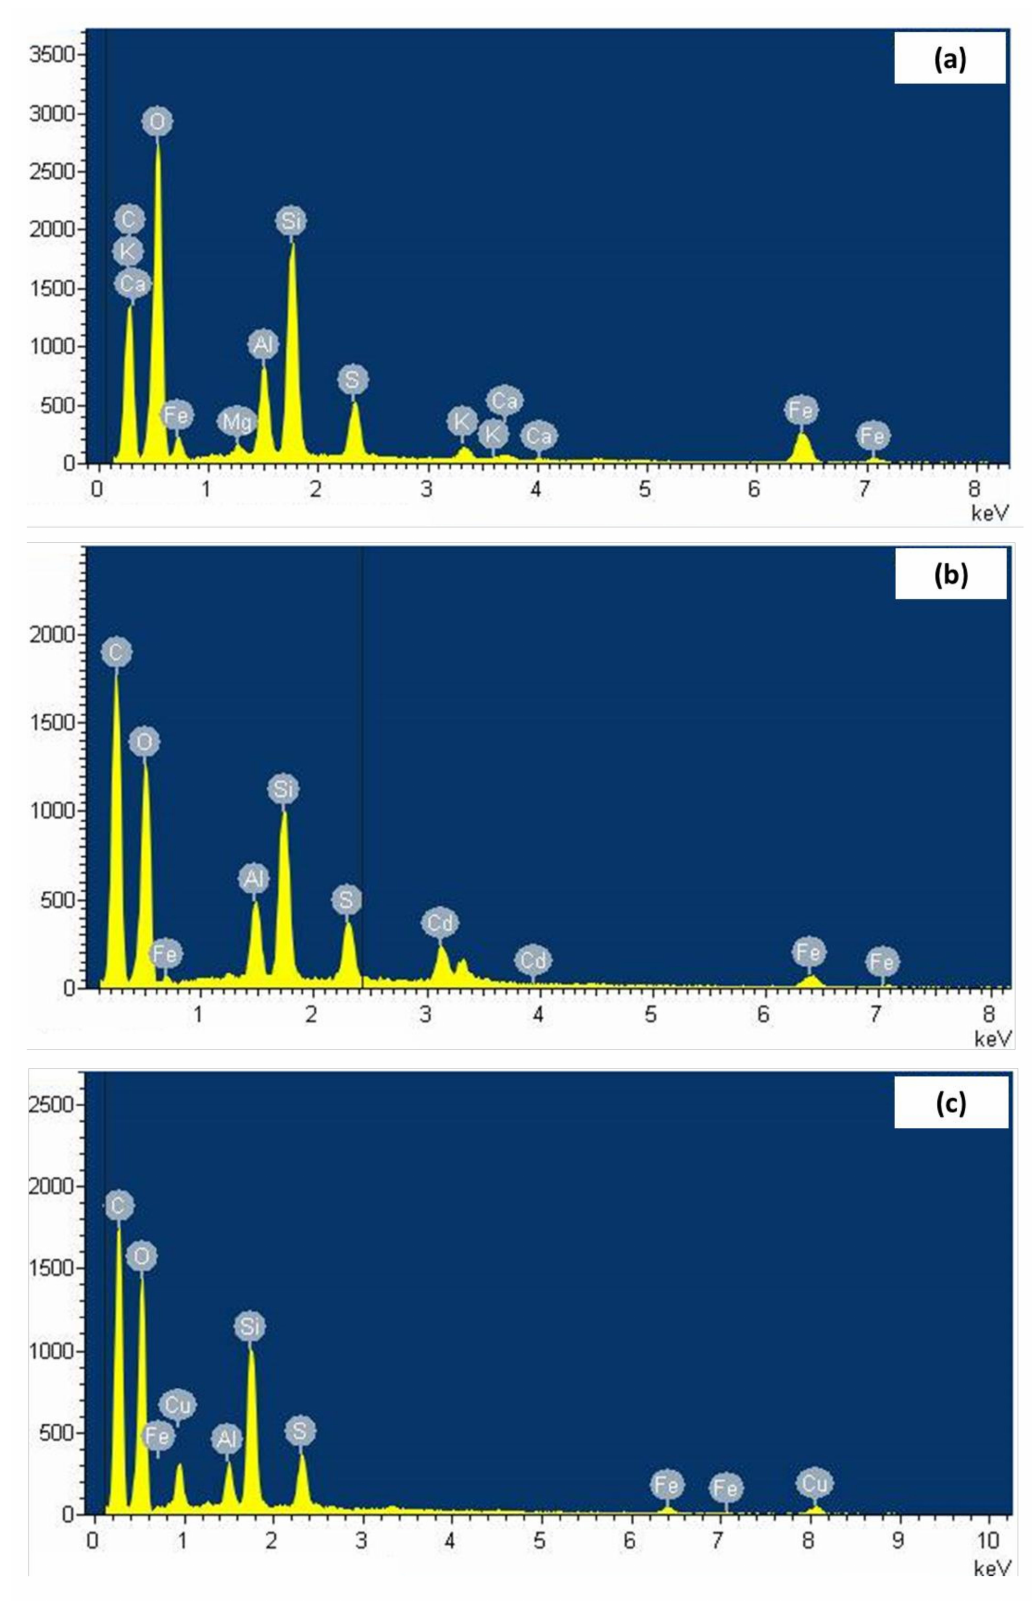
Figure 8. EDX analysis of: ( a ) raw lignite; ( b ) cadmium-loaded lignite; ( c ) copper-loaded